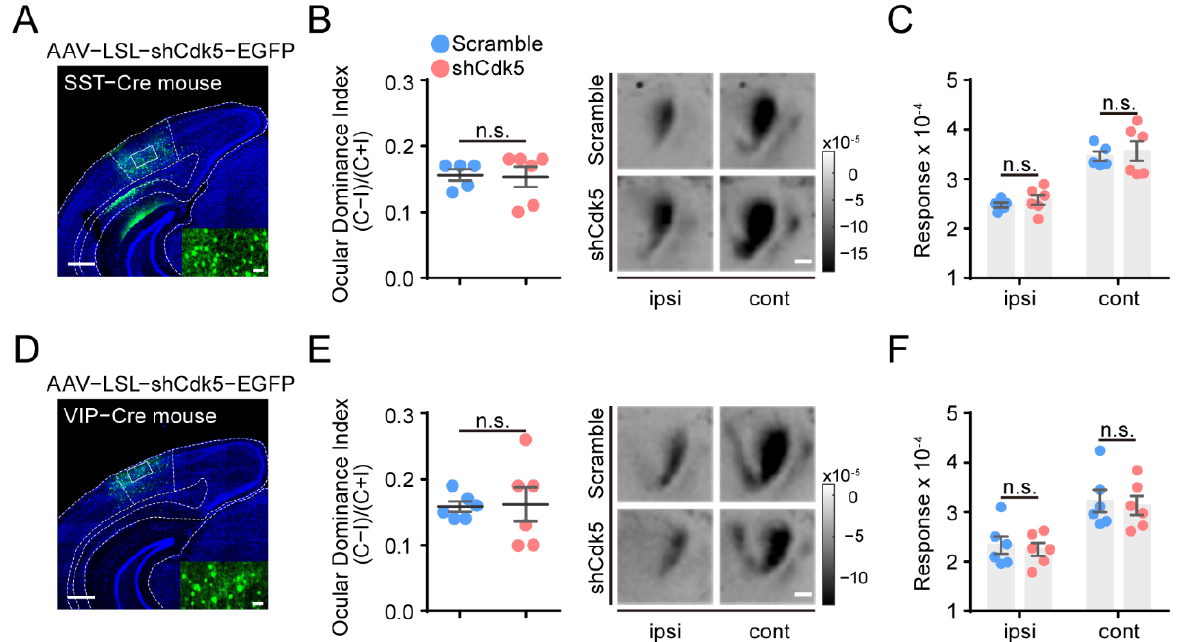
Figure 4. Cdk5 knockdown in SST or VIP neurons of V1 cannot reactivate OD plasticity in adult mice. ( A , D ) Representative images of injection with AAV–shCdk5 in the V1 of SST-Cre ( A ) and VIP-Cre ( D ) mice. Scale bar, 500 μ m. Enlarged view shown in inset. Scale bar, 50 μ m. ( B ) Left: After 4d MD, average ODI measured in adult SST-Cre mice transfected with AAV–scramble (blue) or AAV–shCdk5 (erythrinus) (t = 0.14, p = 0.89, unpaired t -test). Right: Example intrinsic signal images from SST-Cre mice injected with AAV–scramble and AAV–shCdk5 after MD. Scale bar, 500 μ m. ( C ) Maximum magnitude of responses elicited by the stimulus to the ipsilateral eye or contralateral eye after 4d MD in adult SST-Cre mice (F(1, 18) = 0.61, p > 0.05, two-way ANOVA with Tukey’s post hoc test). ( E , F ) Quantification of visual cortical activation in VIP-Cre mice. ODI ( E ) (t = 0.12, p = 0.91, unpaired t -test) and V1 activation ( F ) (F(1, 20) = 0.23, p > 0.05, two-way ANOVA with Tukey’s post hoc test) are illustrated as ( B , C ). ODI: ocular dominance index; MD: monocular deprivation; ipsi: ipsilateral